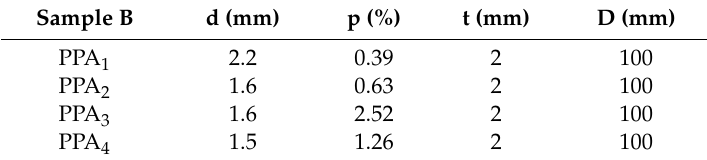
Table 4. Parameters of the four parallel-arranged perforated panel absorbers for 150–450